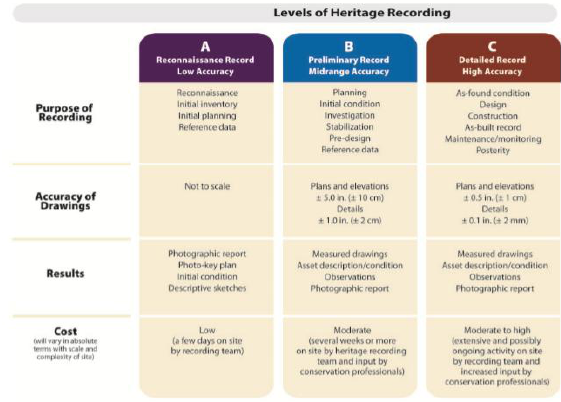
Figure 3. Levels of documentation A-rapid, B-detailed and C highly accurate. (Letellier,